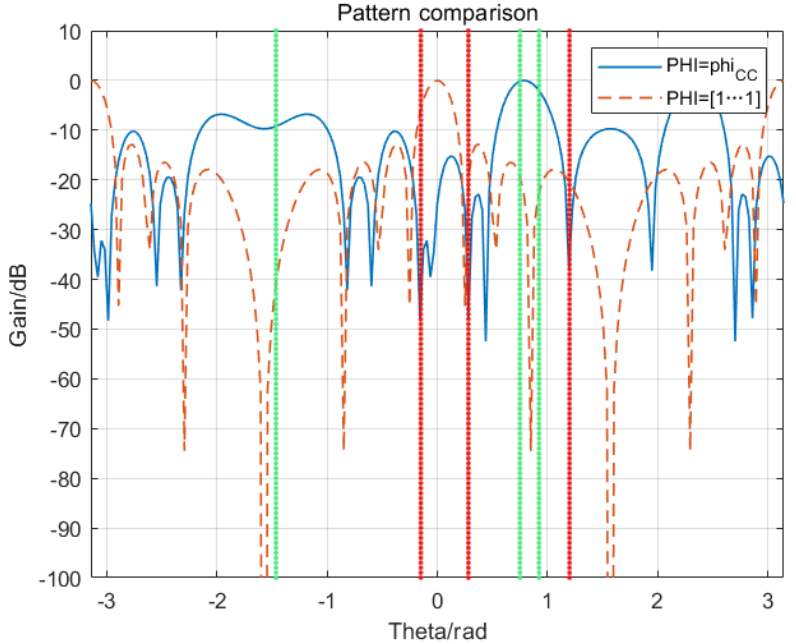
Figure 3. Pattern comparison of the CC algorithm based on DMA and the same-dimensional homo- geneous array antenna.